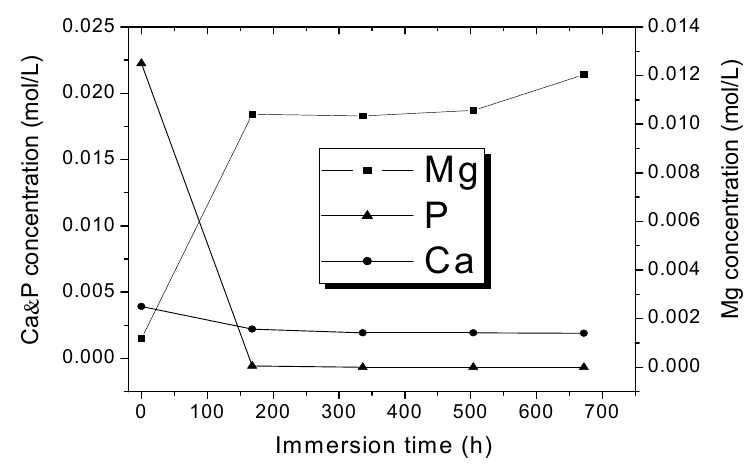
Figure 8. Ionic concentration of remaining SBFs.